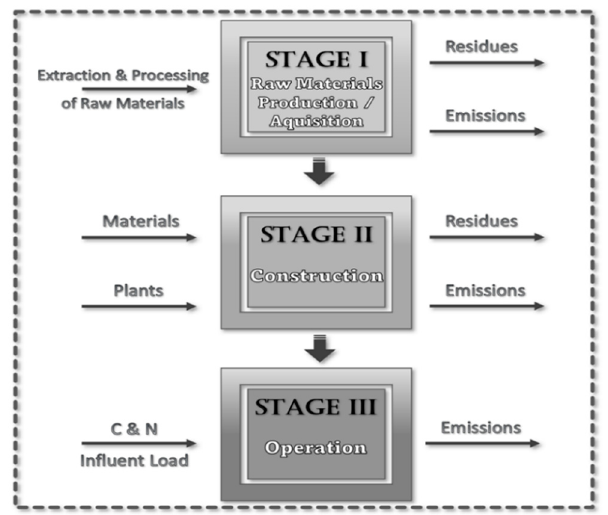
Figure 2. System